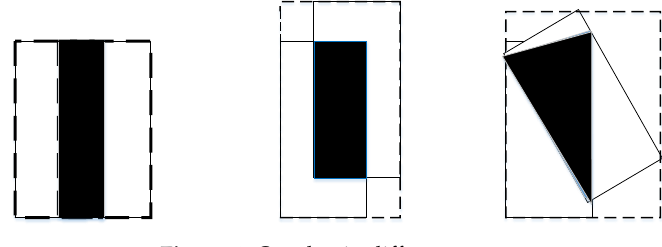
Figure 4. Overlap in different ways.